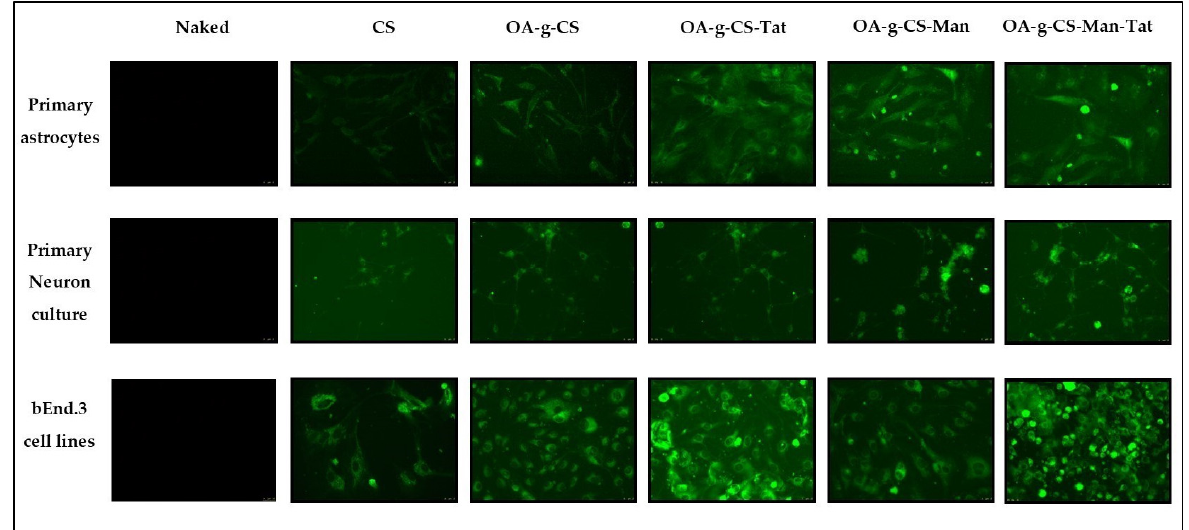
Figure 8. Qualitative analysis of in vitro transfection efficiency of naked pGFP, CS–pGFP, OA-g-CS–pGFP, OA-g-CS-Man–pGFP, OA-g-CS-Tat–pGFP, and OA-g-CS-Man-Tat–pGFP against primary astrocytes, primary neurons, and bEnd.3 cells. Images were taken at 20× magnification.